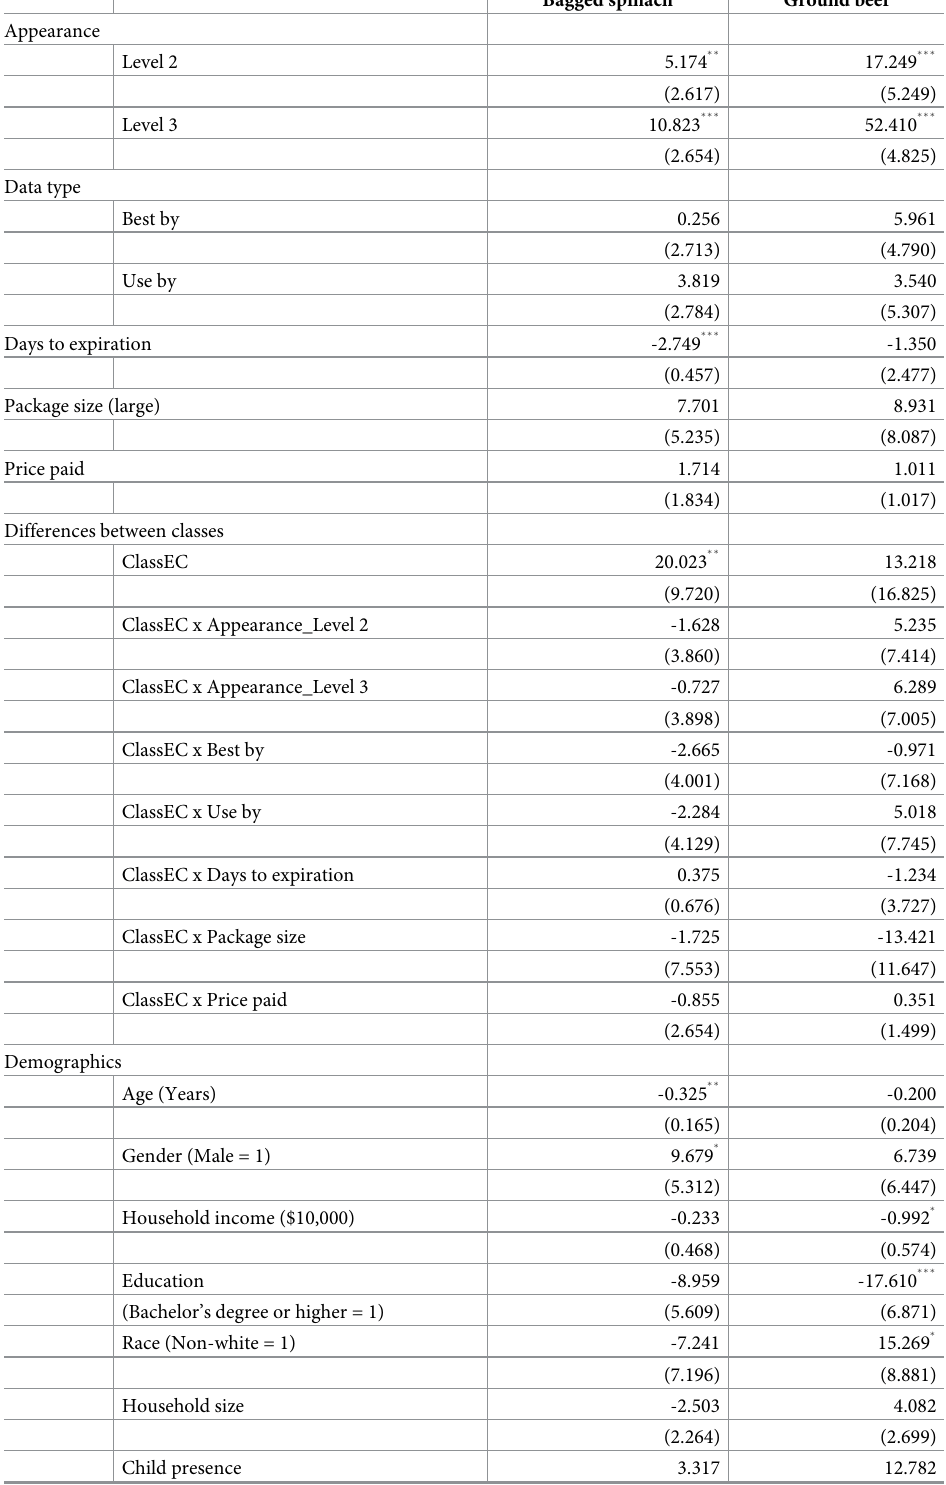
Table 6. Regression results: Tendency to waste products by product attributes a